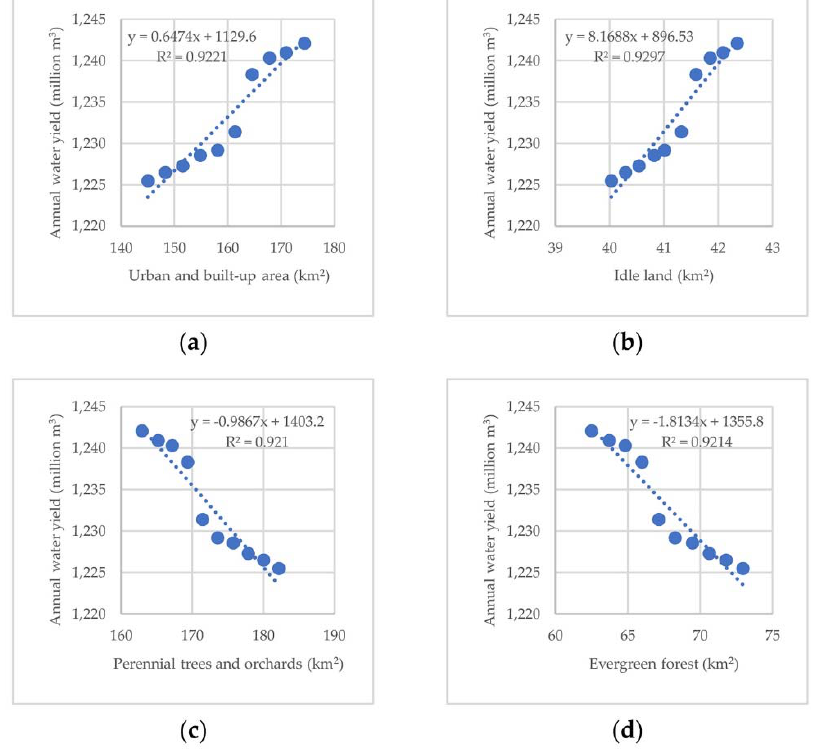
Figure 13. Simple linear regression analysis between LULC type and water yield under wet year scenario.